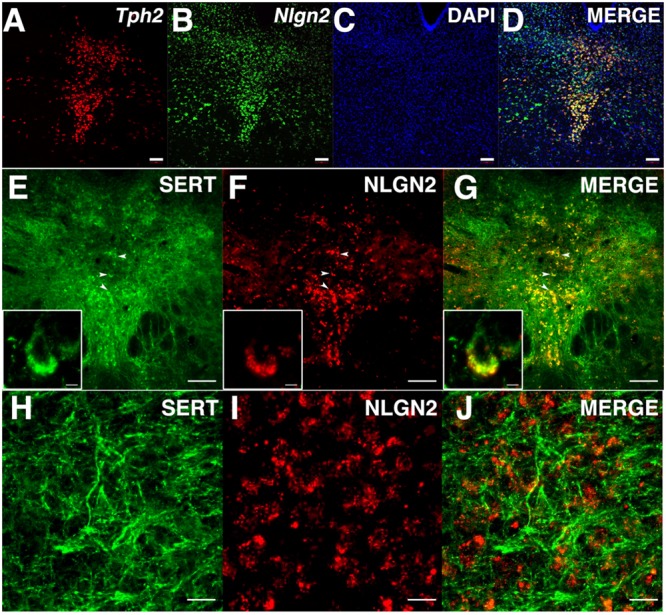
NLGN2 mRNA and proteins are expressed in the dorsal raphe nucleus (DRN) and co-localize with SERT in 5-HT cell bodies. (A–D)
Nlgn2 mRNA co-localizes with Tph2 gene expression in DRN 5-HT neurons (scale bar: 100 μm); (E–G) NLGN2 proteins co-localize with SERT on 5-HT cell bodies in DRN (arrowheads, scale bar: 100 μm). Insets: confocal image of NLGN2:SERT co-localization on the cell body a single 5-HT neuron (scale bar: 5 μm); (H–J) SERT expressed on midbrain axonal fibers of 5-HT neurons but does not co-localize with NLGN2 (scale bar: 5 μm).